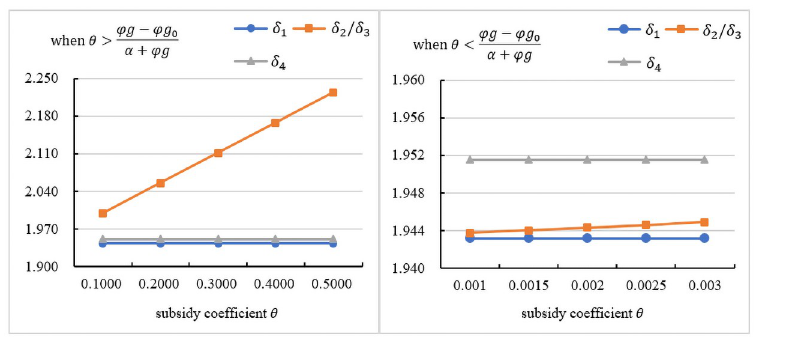
Fig 3. The influence of the subsidy coefficient on the assembly